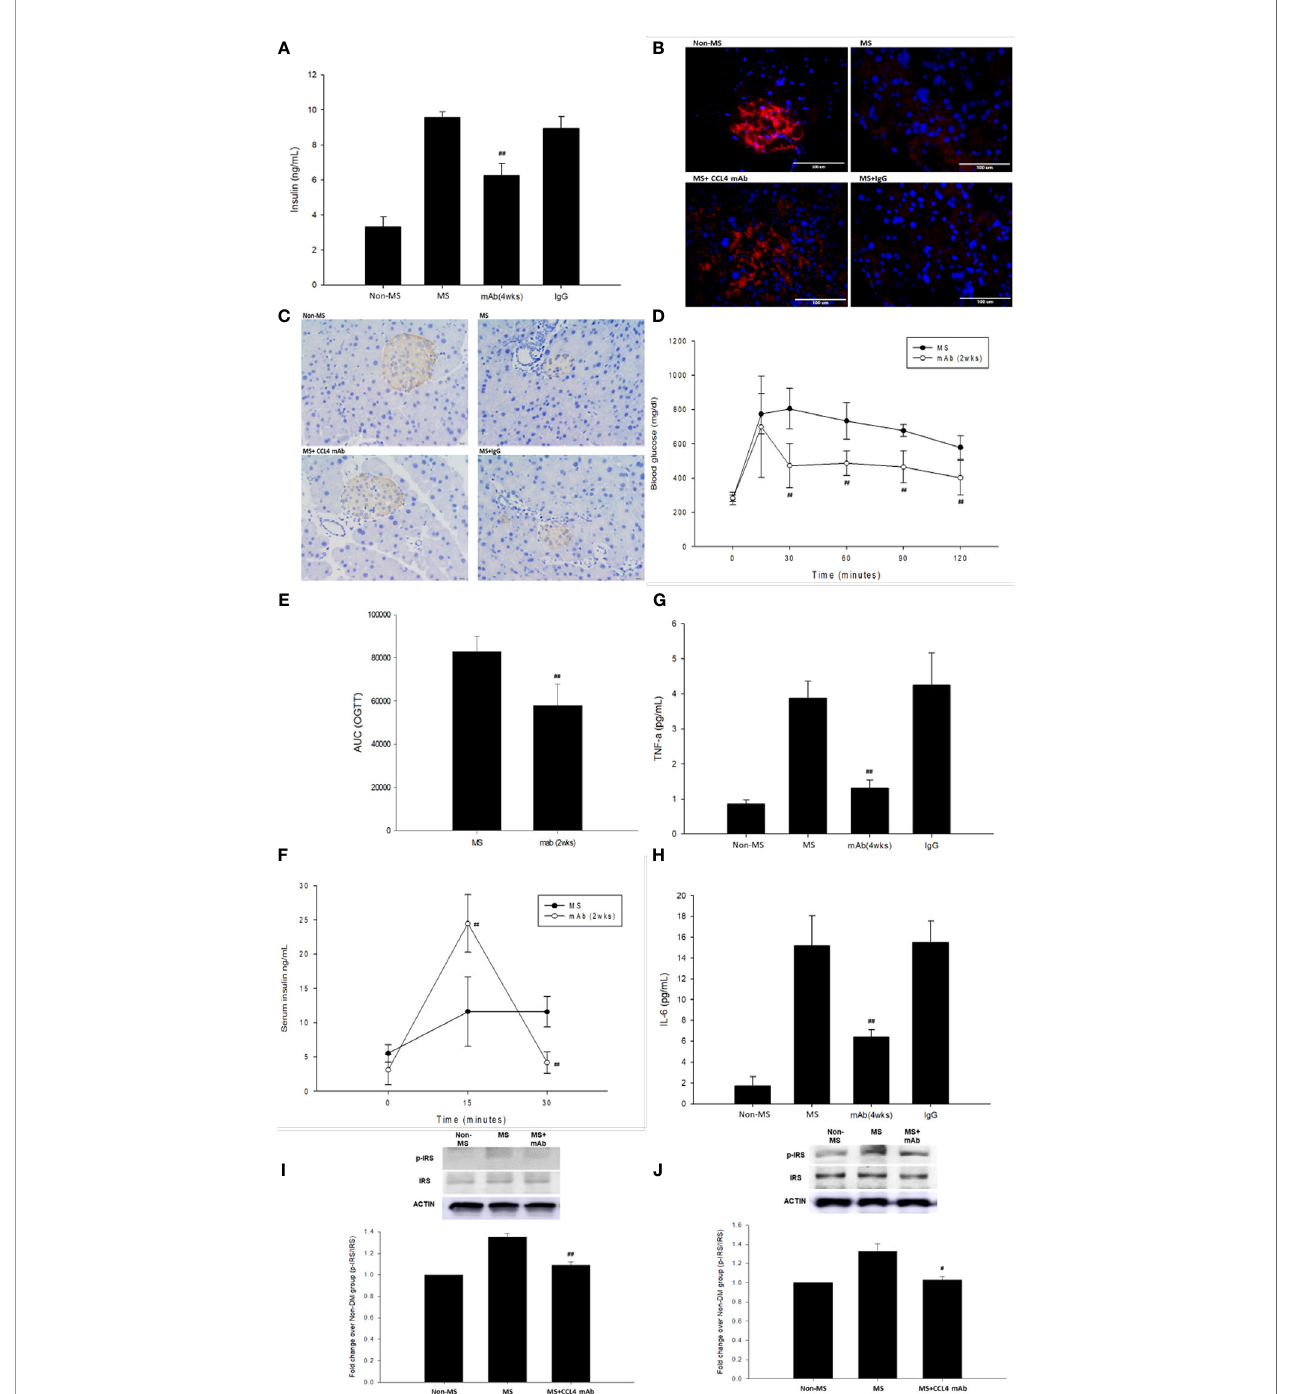
FIGURE 4 | The effects of CCL4 inhibition on pancreatic tissues from metabolic syndrome mice. Serum insulin levels in high-fat diet metabolic syndrome mice (n=6; A ). The CCL4 inhibition groups showed more insulin expression in the pancreas than the IgG-treated metabolic syndrome mice (red; B ) (dark brown; C ). The OGTT was conducted after CCL4 antibody injections for 2 weeks (n=6; D ). AUCs of the OGTT calculated from the original graph (n=6; E ). Insulin levels during the OGTT (n=6; F ). Serum TNF- a and IL-6 levels in metabolic syndrome mice (n=6; G, H ). CCL4 inhibition prevented the increased phosphorylation of IRS-1 in skeletal muscle and liver tissues (n=3; I, J ), indicating the improvement of insulin signaling in metabolic syndrome mice. # > P <0.05, ## P<0.01 compared with DM+IgG mice (A, G, H) or untreated metabolic syndrome mice (D – F, I, J)